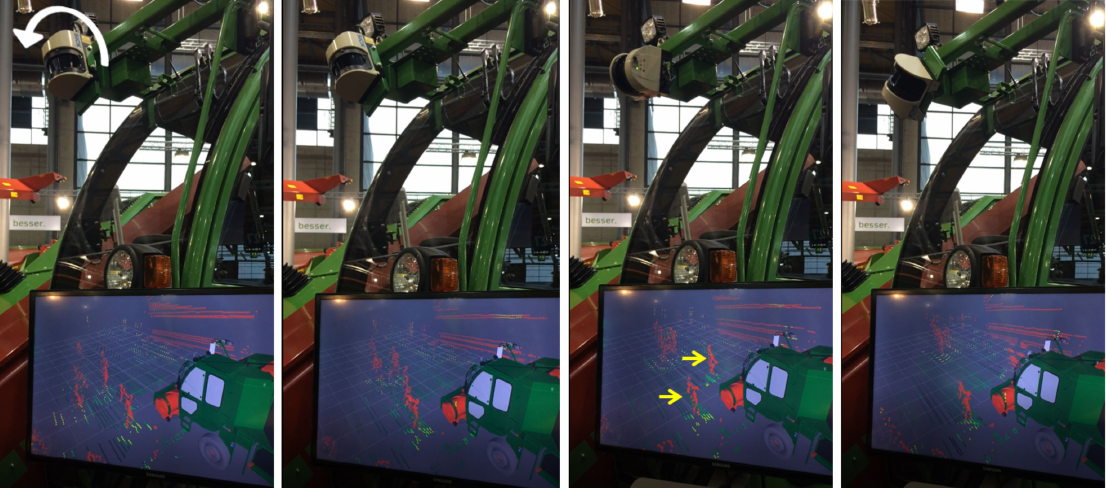
Figure 3. The sequence of images shows the clockwise rotation of the 2D laser scanner (white arrow) in the direction of travel and the output of the processed scanner data as a 3D point cloud on a monitor. Visitors to the fair can be seen passing by (yellow arrows). (Own